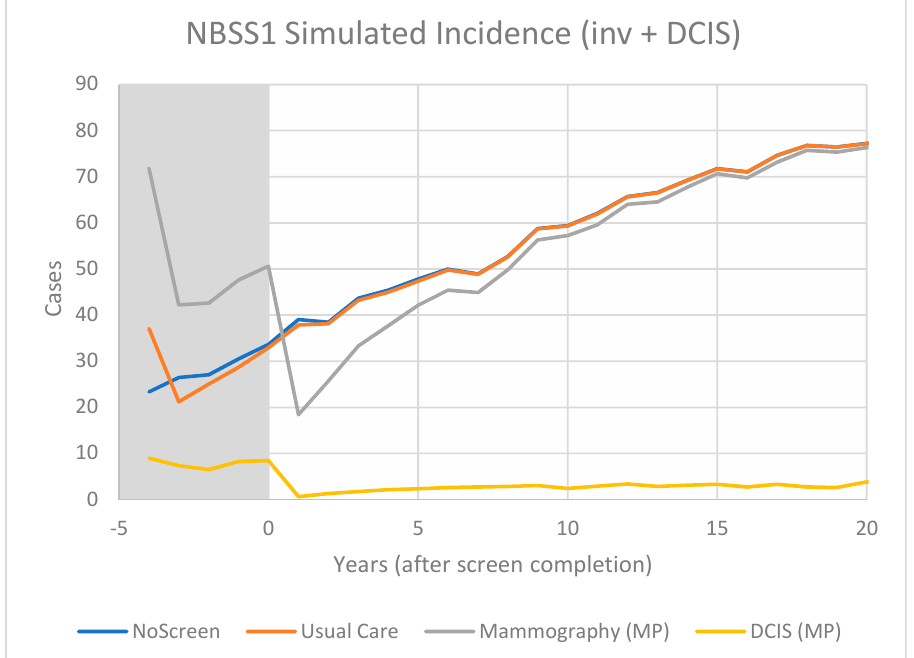
Figure 4. Predicted cases of breast cancer (OncoSim-Breast model) for women who are unscreened and in the Mammography or Usual Care arms of the CNBSS1 trial.